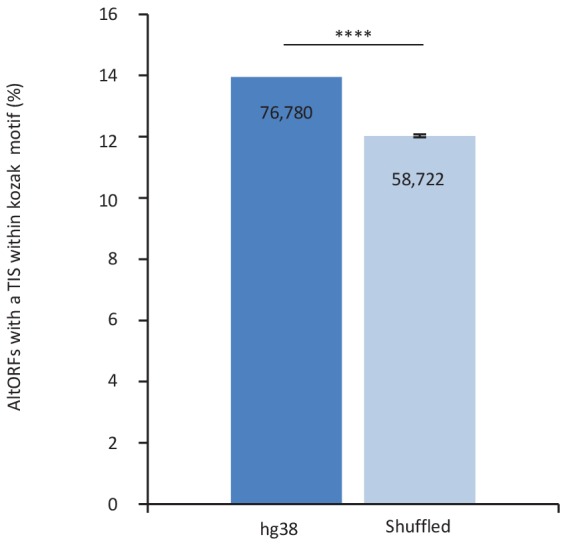
The proportion of altORFs with a translation initiation site (TIS) with a Kozak motif in hg38 is significantly different from 100 shuffled hg38 transcriptomes.Percentage of altORFs with a TIS within an optimal Kozak sequence in hg38 (dark blue) compared to 100 shuffled hg38 (light blue). Mean and standard deviations for sequence shuffling are displayed, and significant difference was defined by using one sample t-test. ****p<0.0001. Note that shuffling all transcripts in the hg38 transcriptome generates a total of 489,073 altORFs on average, compared to 539,134 altORFs in hg38. Most transcripts result from alternative splicing and there are 183,191 unique altORFs in the hg38 transcriptome, while the 489,073 altORFs in shuffled transcriptomes are all unique. Figure 1g shows the percentage of unique altORFs with a kozak motif (15%), while the current figure shows the percentage of altORFs with a kozak motif relative to the total number of altORFs (14%).10.7554/eLife.27860.007Figure 1—figure supplement 2—source data 1.Proportion of altORFs with a Kozak motif in hg38 and shuffled hg38.